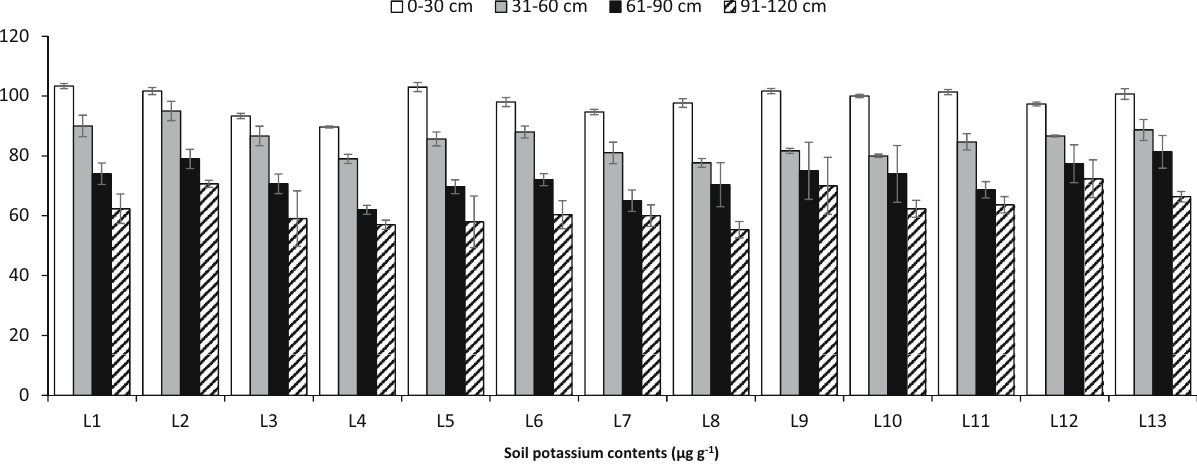
Figure 1: Soil organic matter status of di ff erent locations of mango orchards in the vicinity of Multan. Vertical bars represent standard error.